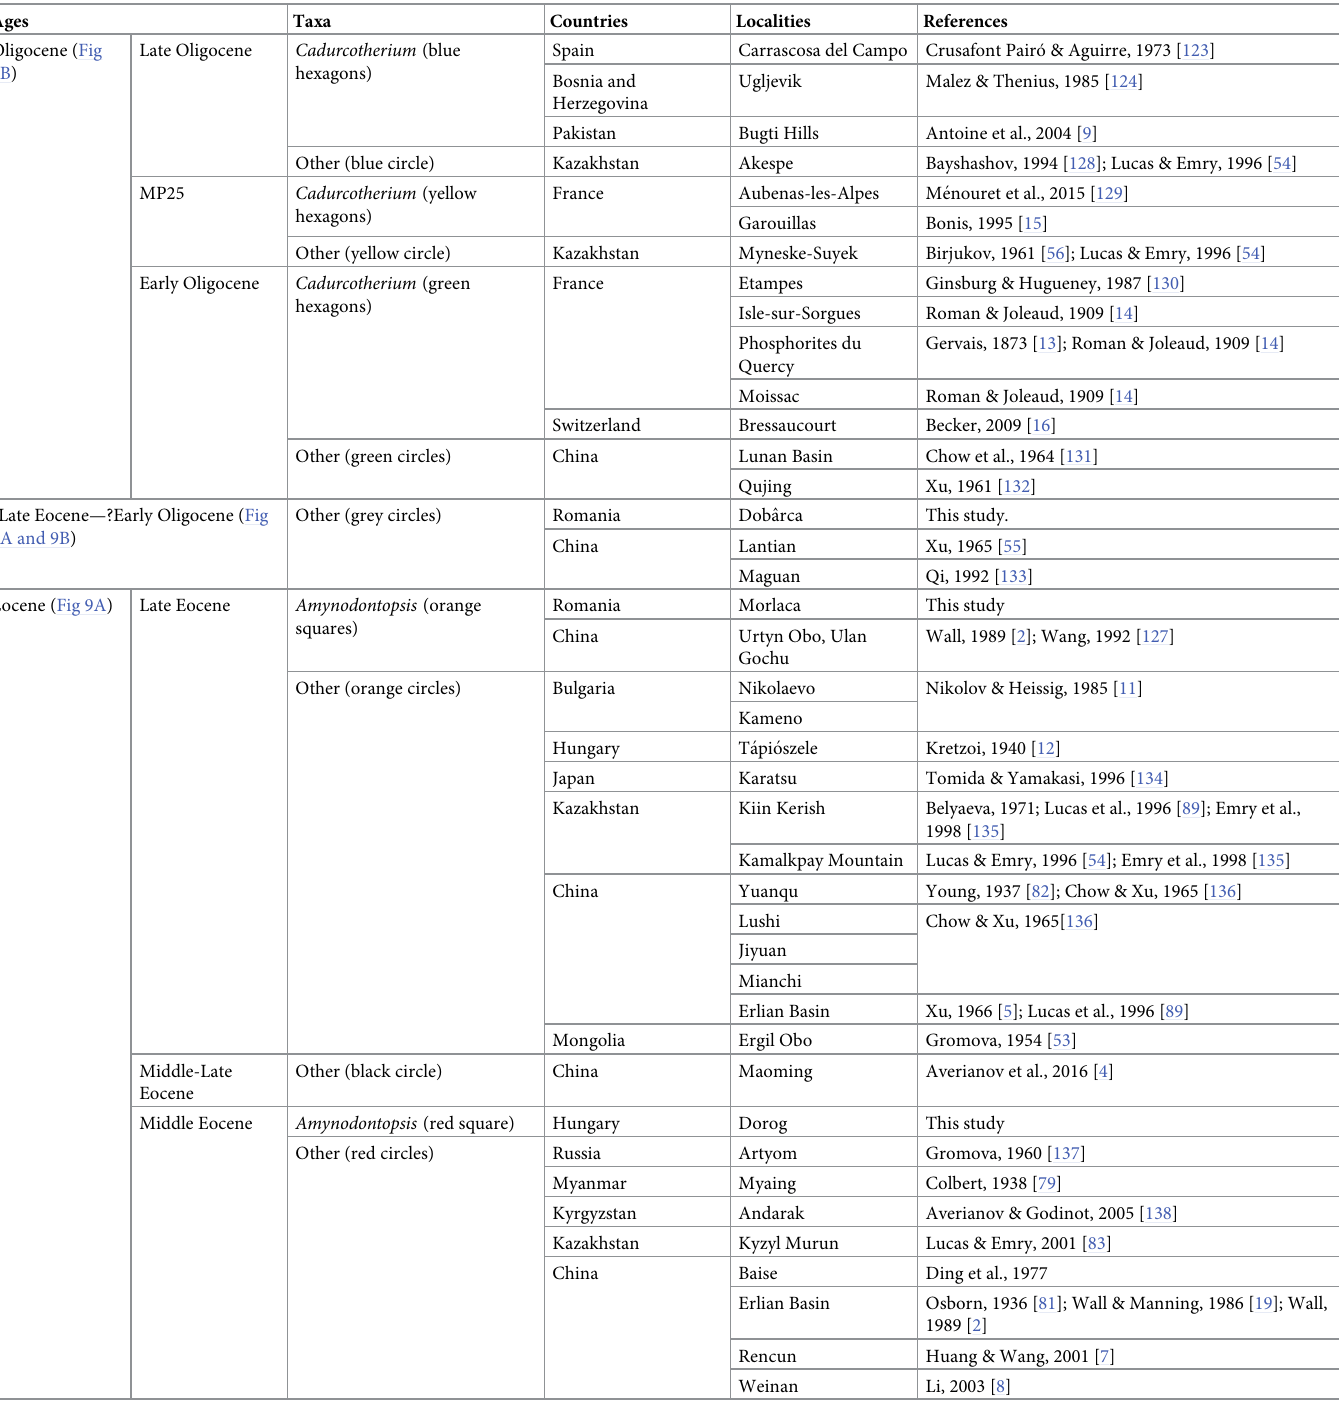
Occurrences with corresponding symbols and colours are also reported on Fig